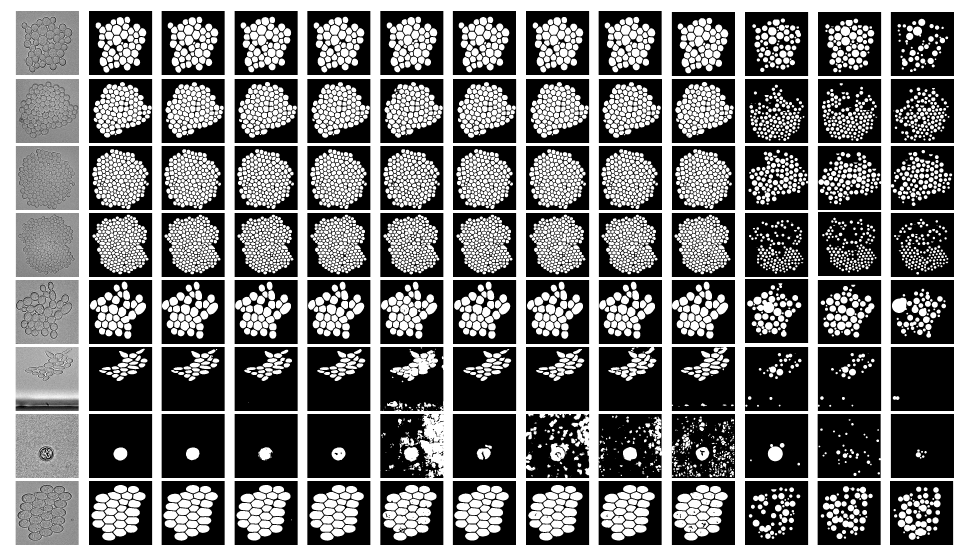
Figure 9. An example of segmentation images predicted by different models.